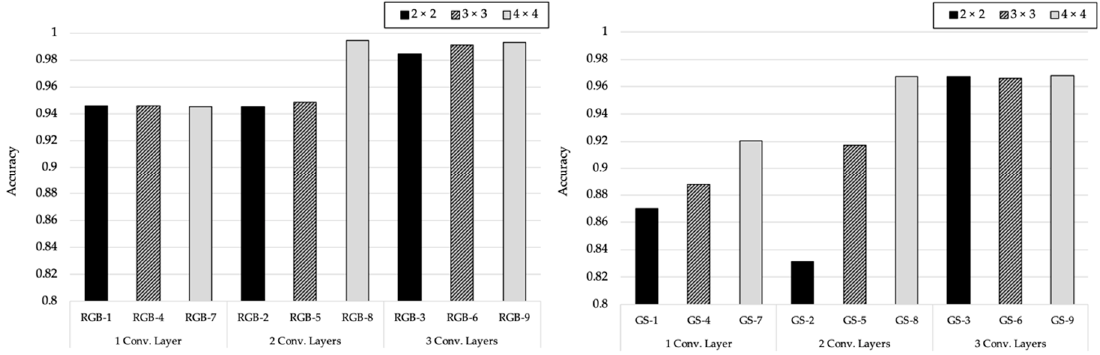
Figure 6. Comparison of Accuracy by size of kernel in case of CSE-CIC-IDS 2018.